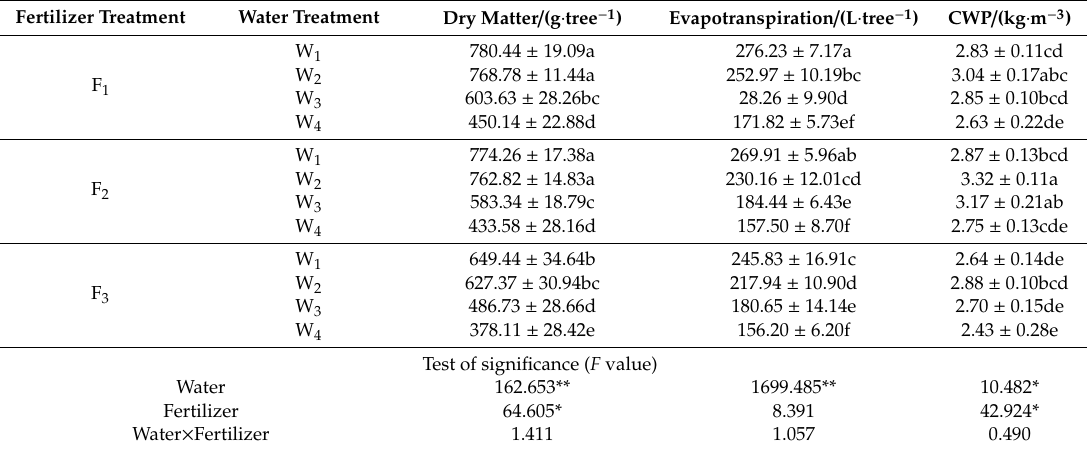
Table 3. E ff ects of di ff erent water and fertilizer treatments on dry matter, evapotranspiration and crop water productivity (CWP) of young apple trees in 2013.